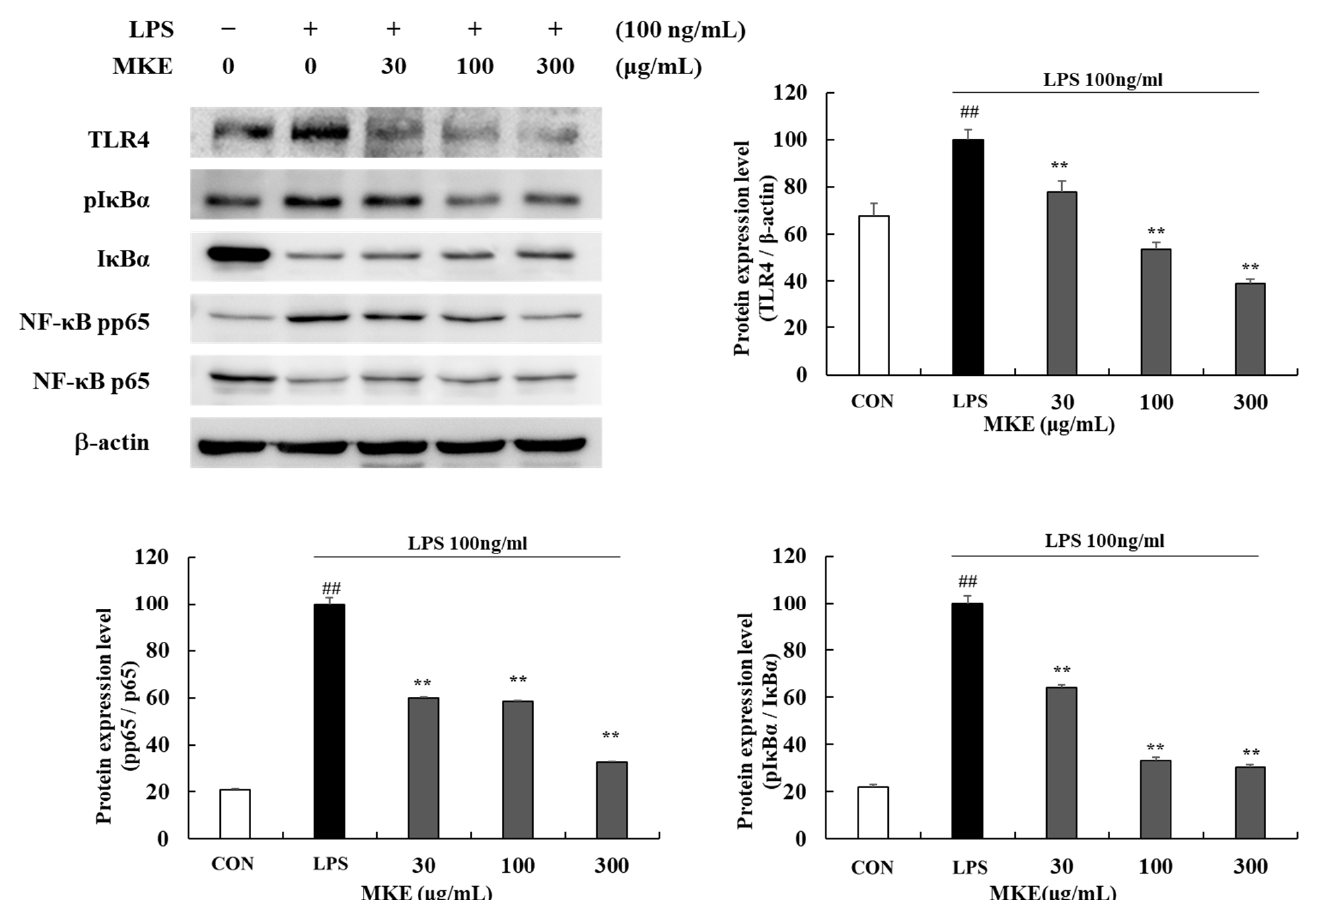
Figure 8. Effects of MKE (30, 100, and 300 μg/mL) on the production of TLR4 and NF-κB factors in LPS-stimulated RAW 264.7 cells. MKE and 100 ng/mL of LPS was added except for in vehicle control group and incubated at 37 °C for 15 min. Protein expression levels of TLR4, pIκBα, IκBα, pp65 and p65 were detected by Western blot. The protein band density was measured by utilizing ImageJ software. β-actin was used as a control for TLR4 protein expression level. Values represent means ± standard deviation. ## p < 0.01 vs. Vehicle control group; ** p < 0.01 vs. LPS-activated control group.